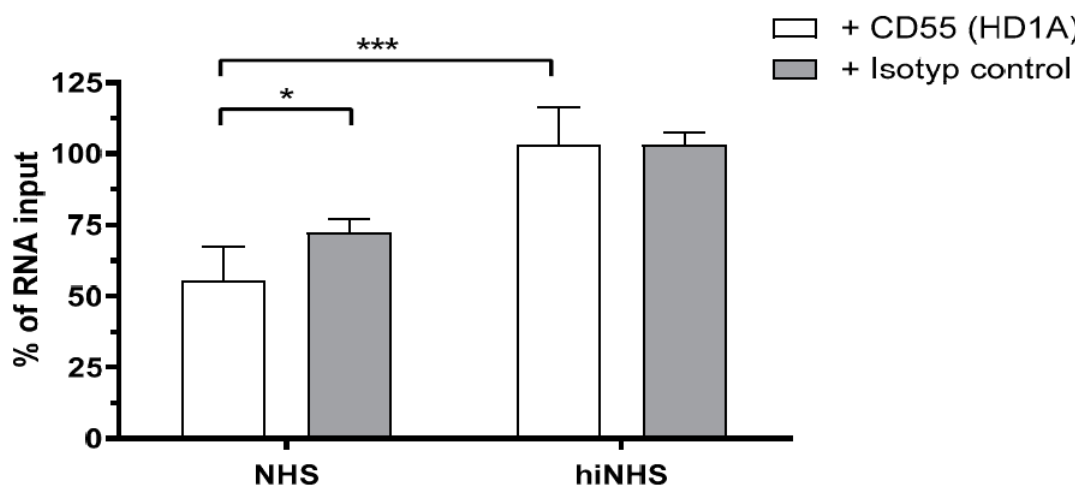
Figure 6. Blocking of CD55 enhances the serum sensibility of ZIKV A549 . ZIKV A549 was pre-incubated with anti-CD55 hybridoma (HD1A) or isotope control antibody before active or heat-inactivated human serum was added. The viral RNA of lysed particles was destroyed by 3 h incubation with RNase A. RNA of complement-mediated lysis (CML)-intact/CML- resistant virions was extracted and analyzed by qRT-PCR. The average value of lysis data using the isotype control was set to 100%. The measurement values were calculated in relation to the average value = 100%. Data were analyzed by two-tailed t -test (* p < 0.05, *** p < 0.001). The assay was performed in